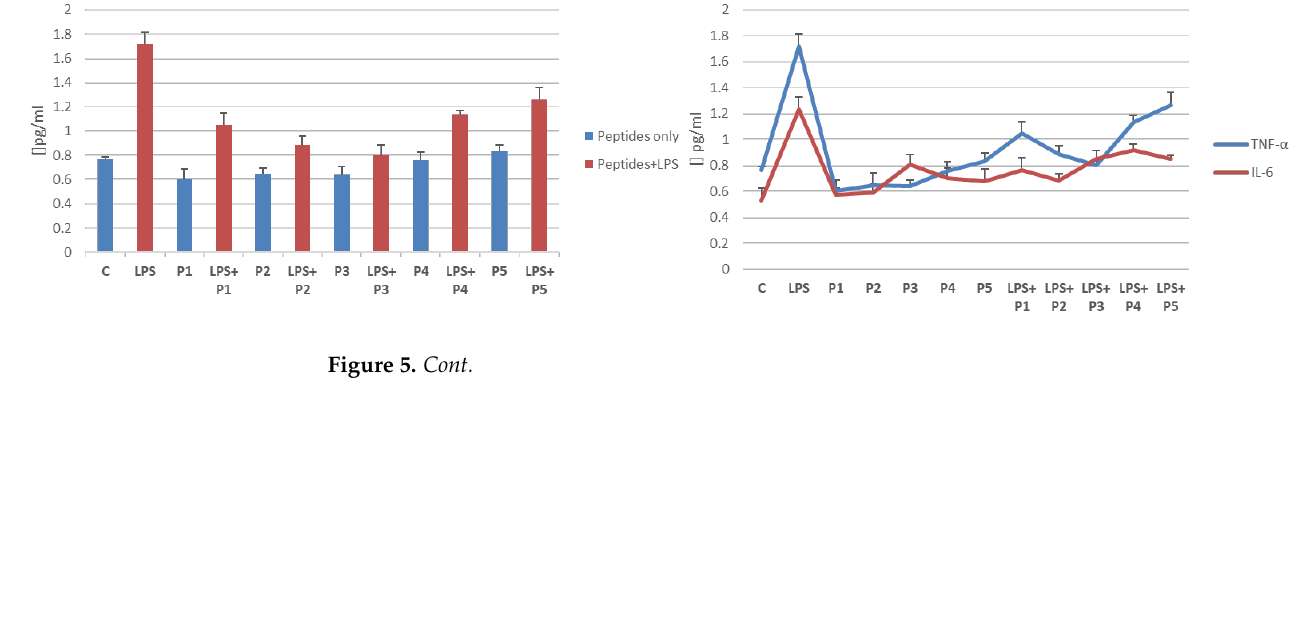
Figure 5. Macrophage cytokine modulation: TNF α , IL-6. and IL-17. Supernatants from treated cells or controls were used as described in Materials and Methods. Data are a mean of at least three in- dependent experiments . 2.6. Confocal Microscopy Confirms That Peptide Mediates the Cytoplasmic STAT1 Transfer into Cells Nuclei A clear shifting of the latent cytoplasmic STAT1 molecules into the nuclei of peptide- treated macrophages was observed through confocal microscopy. As evident in Figure 6, the control differentiated THP-1 cells did not show any significant transfer of the STAT1 into the nuclei. Whereas, upon peptide incubation, most of the peptides were able to acti- vate cytoplasmic transducers passage into the nuclei as marked in Figure 6. The phos- phorylation of the STAT1 molecules allows the unmasking of the nuclear localization site (NLS), determining the translocation into the cell nucleus. The conventional DAPI stain- ing, that specifically binds strongly to adenine–thymine-rich regions in DNA, was used. Subtraction of the background staining was from incubation of fluorescence secondary specific antibody.